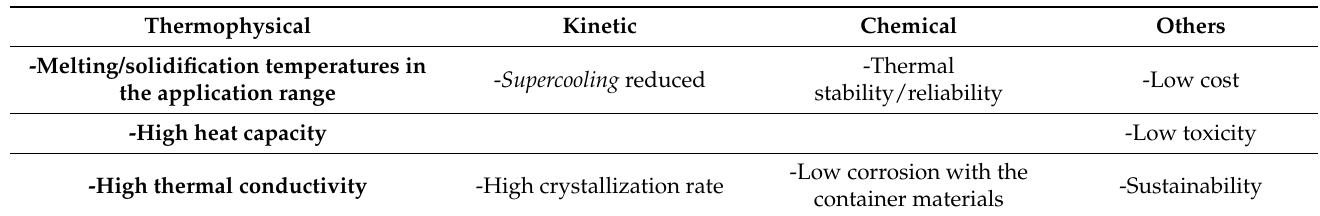
Table 1. Requirements of phase change materials for thermal energy storage.